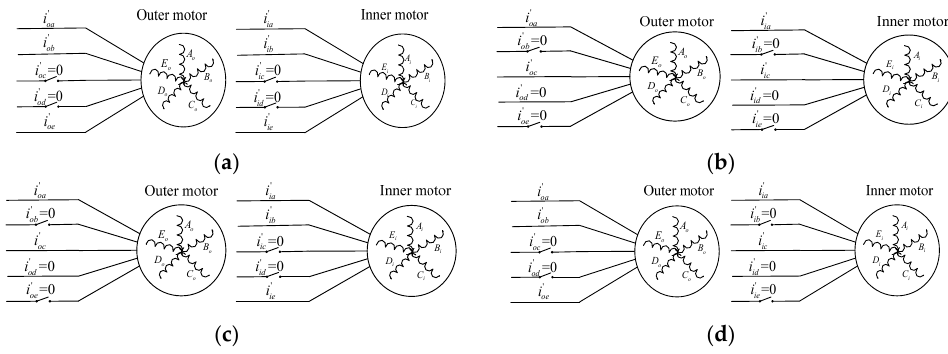
Figure 26. Double ‐ phase open ‐ circuit in both sides of motor fault types. ( a ) Adjacent double ‐ phase Figure 26. Double-phase open-circuit in both sides of motor fault types. ( a ) Adjacent double-phase open ‐ circuit in outer motor and in inner motor; ( b ) non ‐ adjacent double ‐ phase open ‐ circuit in outer open-circuit in outer motor and in inner motor; ( b ) non-adjacent double-phase open-circuit in outer motor and in inner motor; ( c ) adjacent double ‐ phase open ‐ circuit in inner motor with non ‐ adjacent motor and in inner motor; ( c ) adjacent double-phase open-circuit in inner motor with non-adjacent double ‐ phase open ‐ circuit in outer motor; ( d ) non ‐ adjacent double ‐ phase open ‐ circuit in inner motor double-phase open-circuit in outer motor; ( d ) non-adjacent double-phase open-circuit in inner motor with adjacent double ‐ phase open ‐ circuit in outer motor. with adjacent double-phase open-circuit in outer